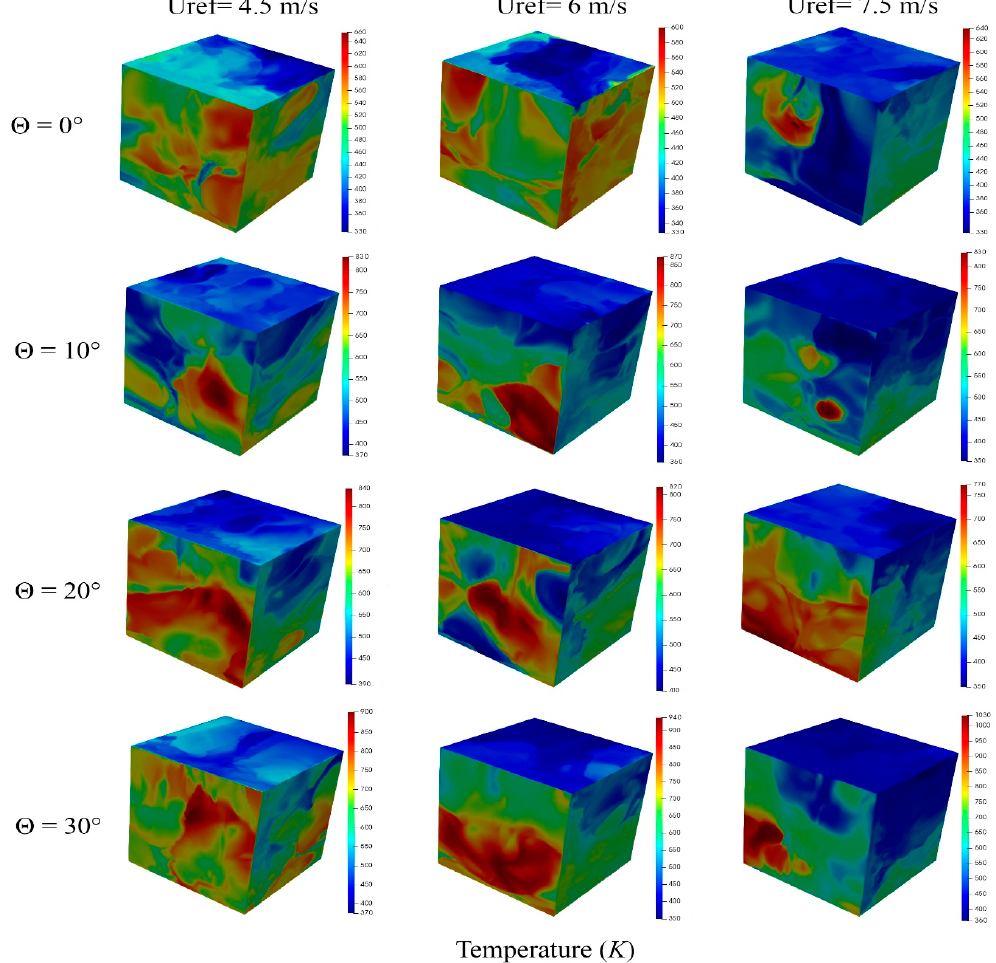
Figure 11. Temperature distribution on the building in U ref = 4.5, 6, and 7.5 m/s and terrain slope 0°, 10°, 20°, and 30°.